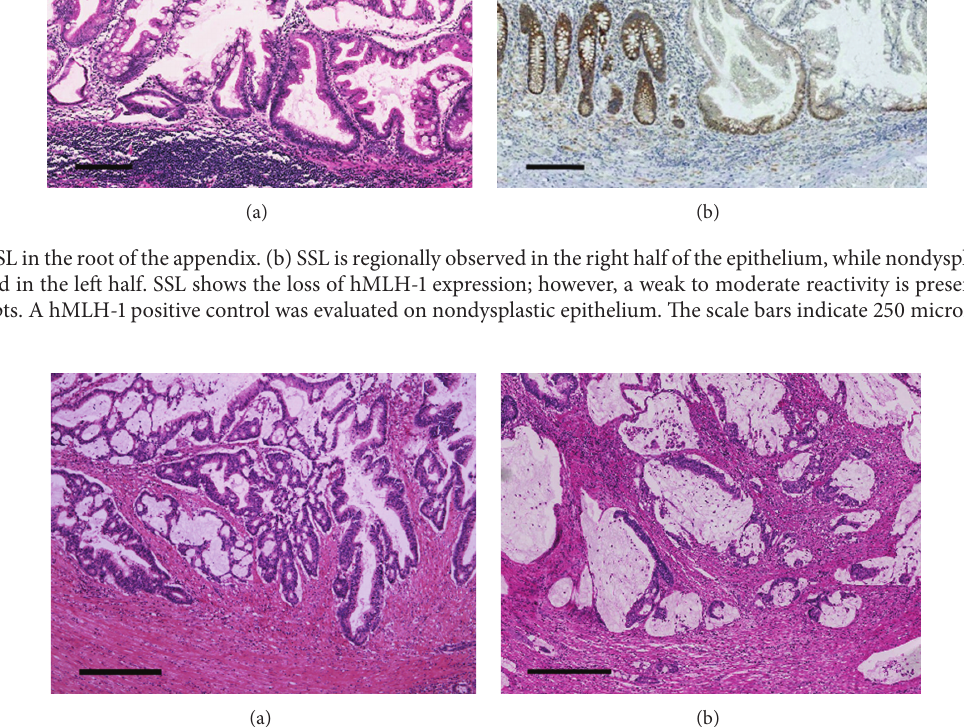
Figure 3: (a) The area of gradual transition between the mucinous adenocarcinoma and SSL in the peripheral side of the appendix, but the serrated structure is not outstanding. (b) The component of mucinous adenocarcinoma without serrated structure. The scale bars indicate 500